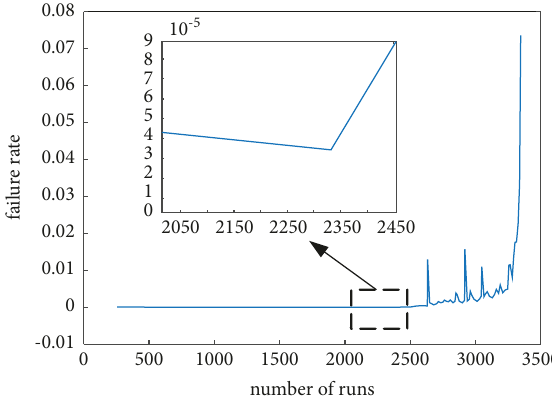
determination. 0